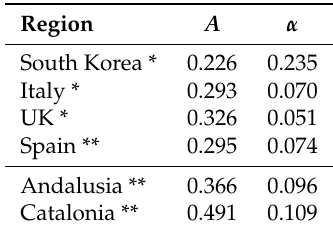
Table 3. Values obtained by fitting Equation (2) to the experimental data in different countries and two Spanish regions (Catalonia and